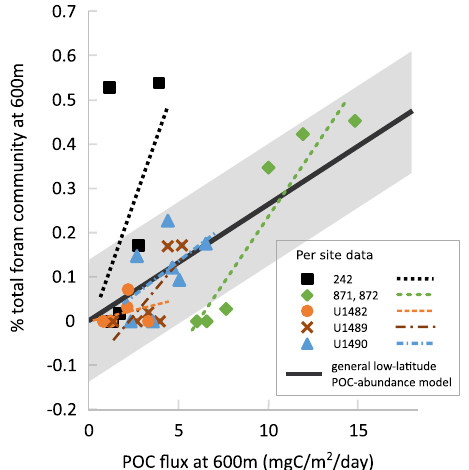
Fig. 4 | POC-abundance model derived from paleo-abundance data and mod- eled particulate organic carbon (POC) fl ux at 600m. Data from ref. 8, with general low-latitudelinear regressionmodel applied(thickblackline).Site-speci fi c linear regressions are shown as dashed lines. The shaded gray is ±1 standard deviation for the general model. Each data point represents data from one site at one time period, covering seven time periods from the mid-Miocene to the pre- industrial present at roughly 2.5 million year time intervals. Data from site 242 (black squares), 871 and 872 (green diamonds), U1482 (orange circles), U1489 (red crosses), and U1490 (blue triangles). More information is available in